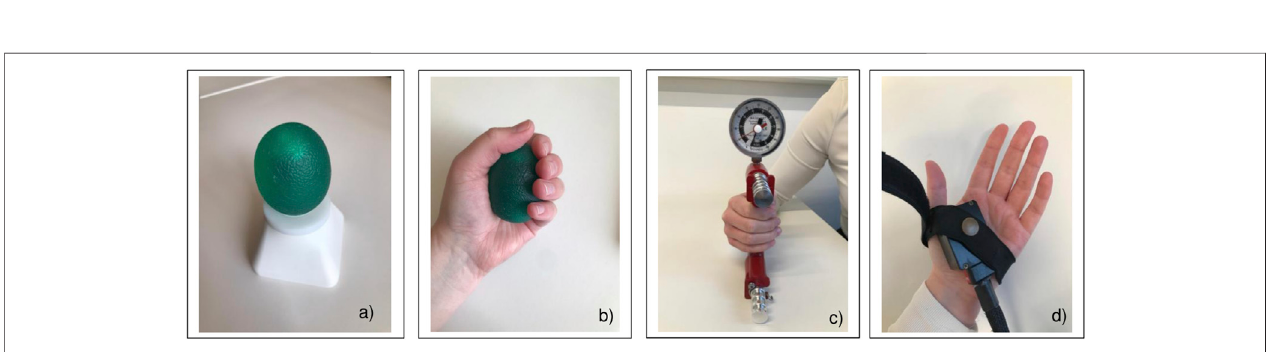
FIGURE 2 | (A) The eEgg (electronic egg) in its docking station. (B) The position of the eEgg during its application with pressure sensors inside. (C) The hand dynamometeranditspositionduringitsapplication. (D) TheapplicationofthethermalstimuliusingtheThermoSensoryAnalyzerpositionedatthelowerpartofthepalm.